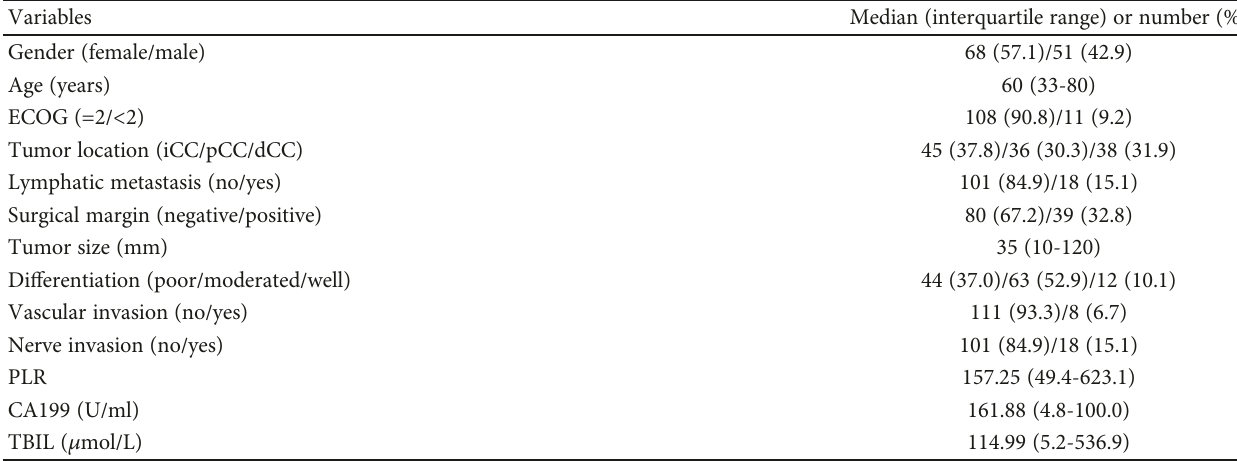
Table 1: Patient demographics of CCA